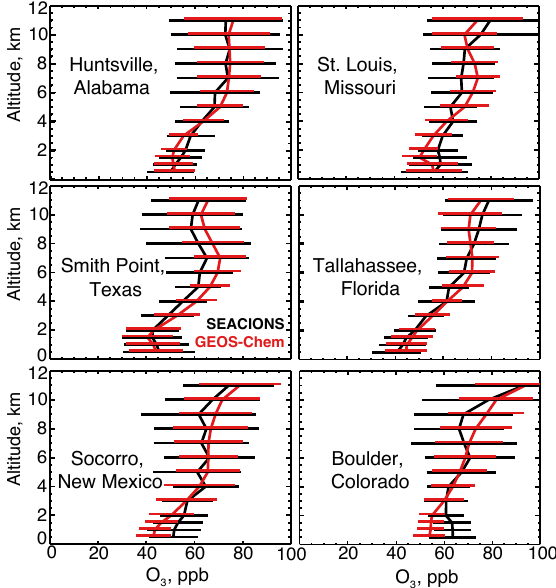
Figure 8. Mean ozonesonde vertical profiles at the US SEACIONS sites (http://croc.gsfc.nasa.gov/seacions/) during the SEAC 4 RS campaign in August–September 2013. An average of 20 son- des were launched per site between 09:00 and 16:00 local time. Ozonesondes at Smith Point, Texas, were only launched in Septem- ber. Model values are coincident with the launches. Data are av- eraged vertically over 0.5km bins below 2km altitude and 1.0km bins above. Also shown are standard